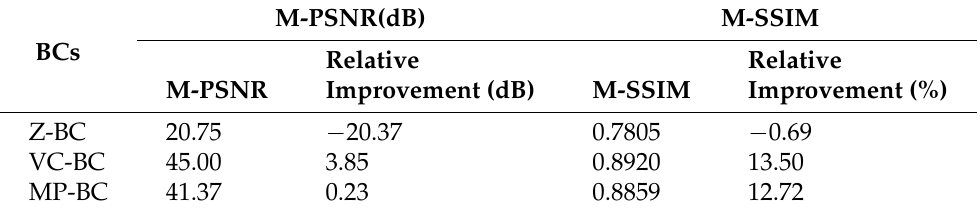
Table 1. Mean peak signal-to-noise ratio (M-PSNR) and mean structural similarity index (M-SSIM) for images deblurred using a 7 × 7 Gaussian kernel with σ R = 2.3 and three different